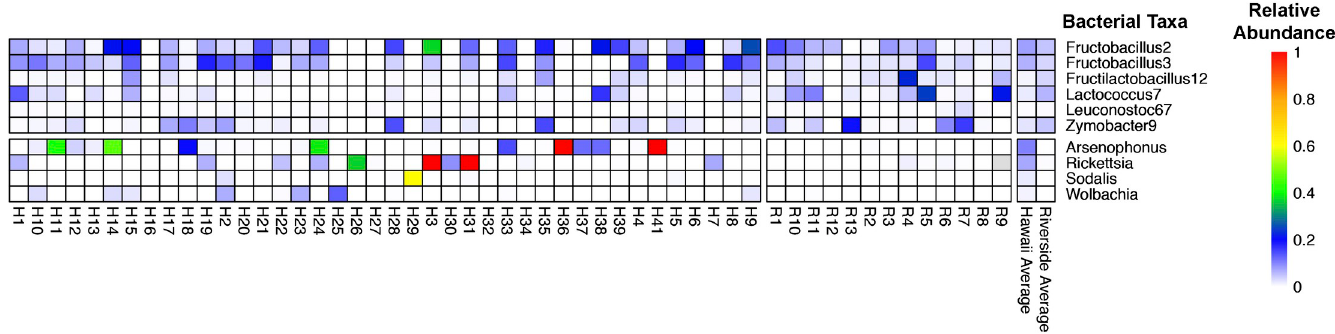
Fig 3. Heatmap of the proportional abundances of Amplicon Sequence Variants (ASVs) identified in at least 50% of our samples and in both locations, and genera that have been identified in other studies as potential insect symbionts. Rows are individual ASVs or genera, columns are individual samples, and heat color represents proportional abundance of these taxa. Final panel is the mean proportional abundance of each taxon in either Hawaiian or Riverside samples.